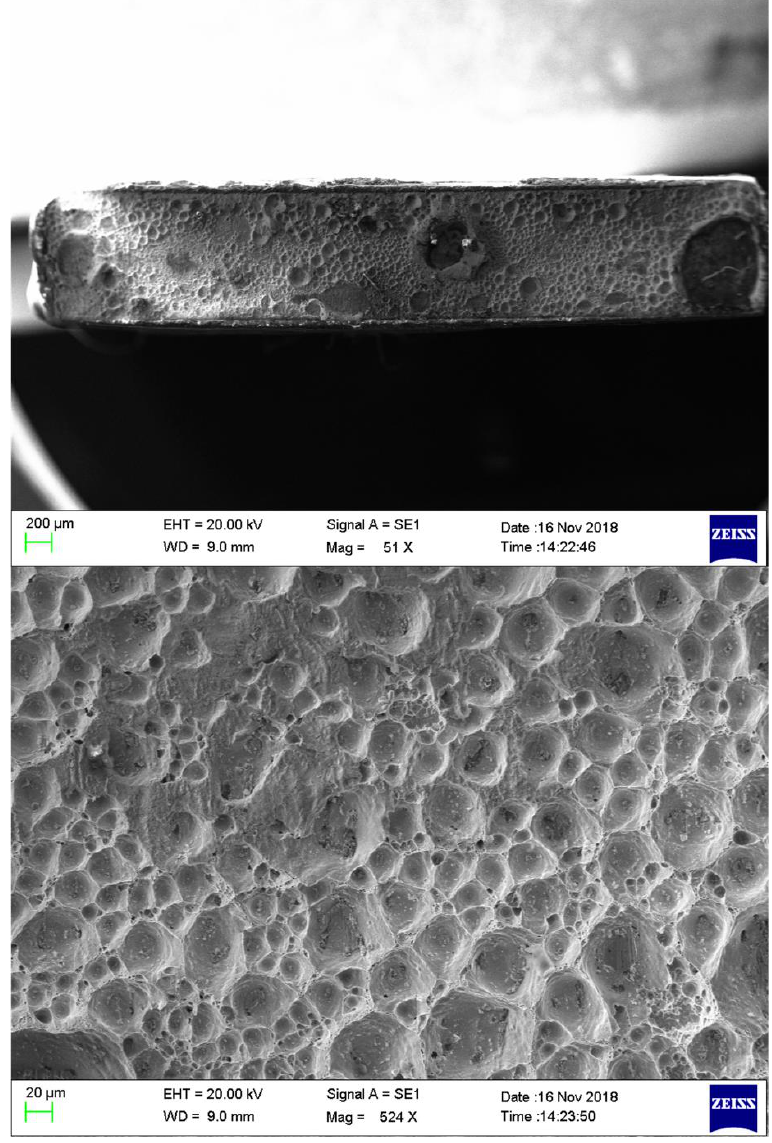
Figure 14. SEM graph of fracture surface at − 70 °C (ductile).